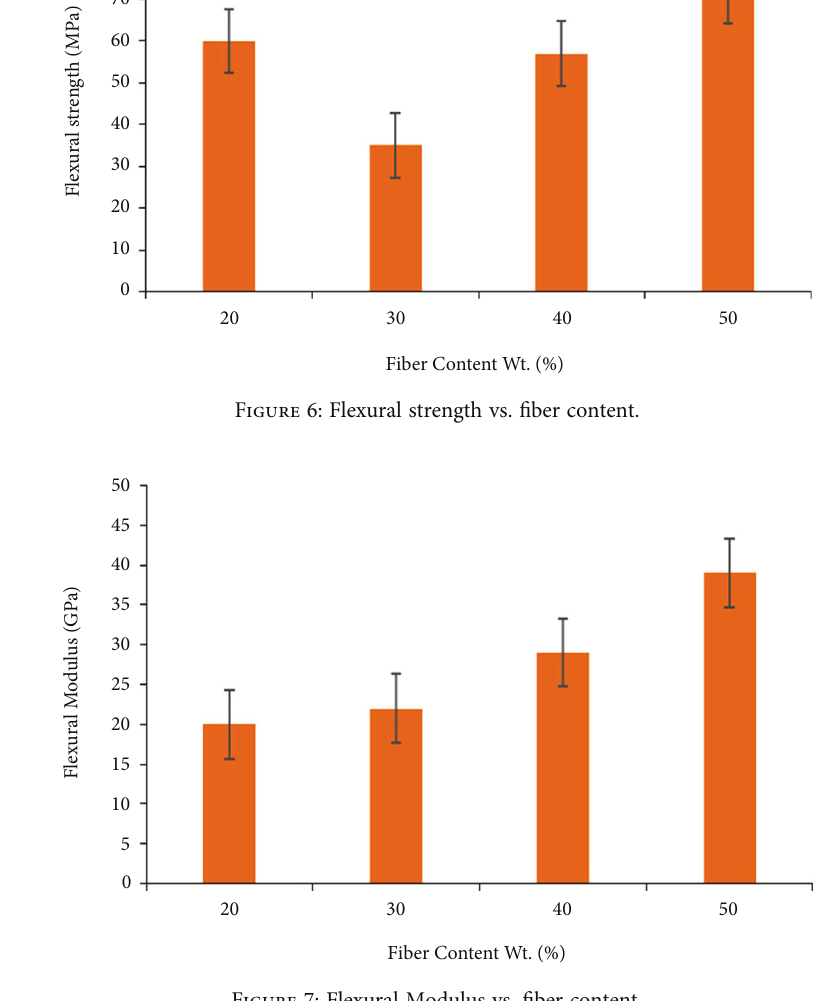
Figure 7: Flexural Modulus vs. fi ber